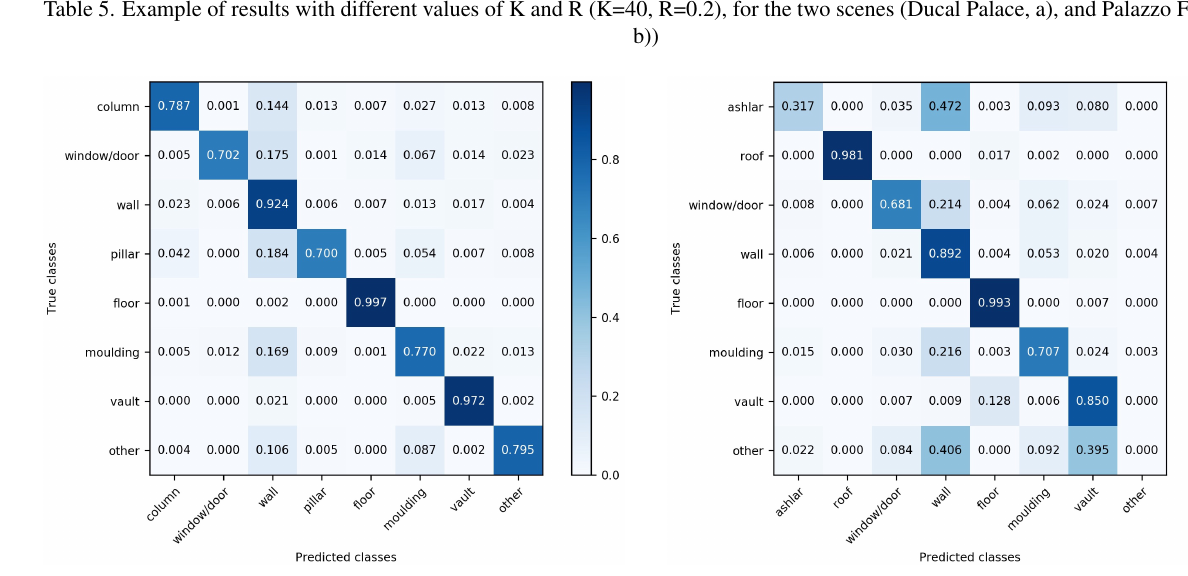
Figure 5. Confusion matrix of the combined approach on the PDU scene.